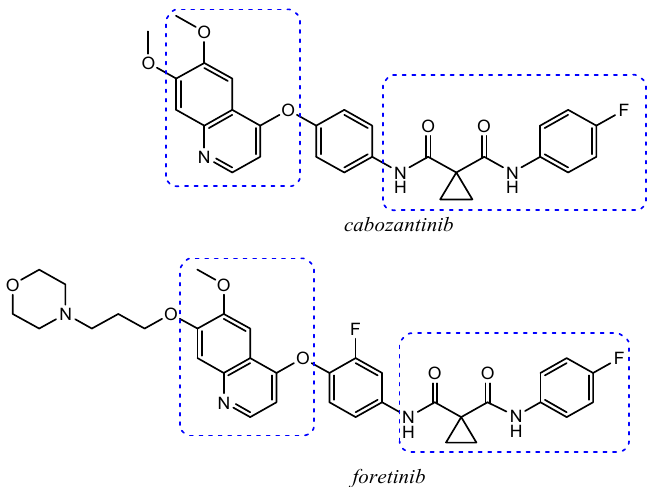
Figure 3. C-Met quinoline inhibitors: cabozantinib and foretinib (in boxes structure analogies are highlighted).